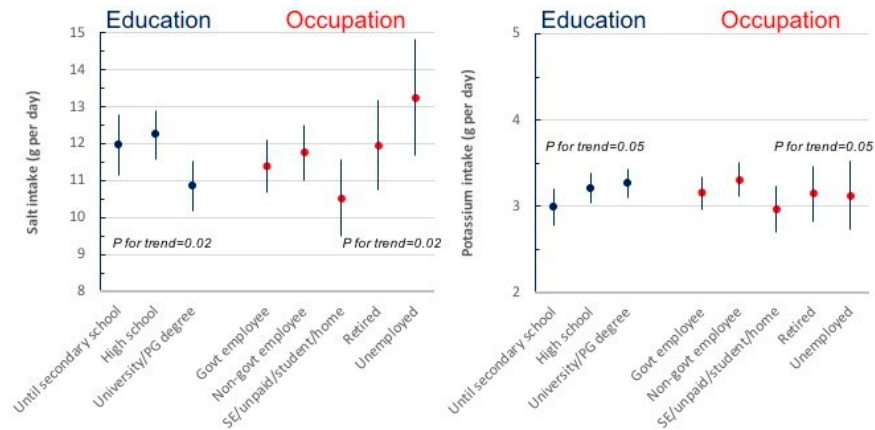
Figure 3. Association between salt and potassium consumption and socio-economic status, defined by educational attainment or occupation, after adjustment for age and sex (results are mean ± SD; P values for linear trend are